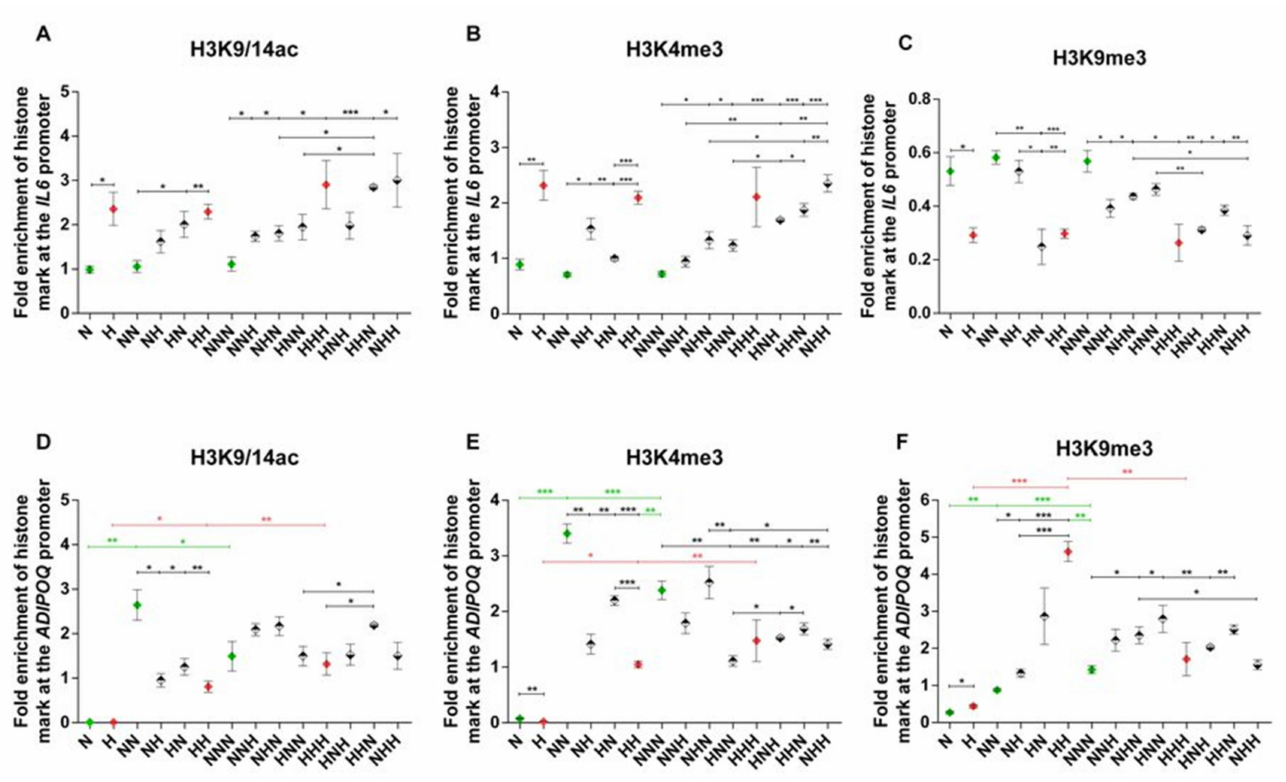
Figure 3. Fold enrichment of H3K9/K14ac, H3K4me3, and H3K9me3 marks in region 1 in the gene promoters of IL6 ( A – C ) and ADIPOQ ( D – F ) in studied human visceral preadipocytes (HPA-vs). Variants differentiated chronically in normoglycemic conditions and chronic hyperglycemia (HG) are colored in green and red, respectively. Variants of transient HG treatment applied during one stage of cell culture are marked with rhombuses with a black upper half and variants exposed to HG during two stages are denoted by rhombuses with a black lower half. Data are presented as mean ± SEM. Significant differences are marked by asterisks according to the p -value criteria: *—0.05 ≥ p > 0.01, **—0.01 ≥ p > 0.001, ***— p ≤ 0.001. Significant differences estimated in one-way ANOVA with a post-hoc Tukey test are marked by green or red